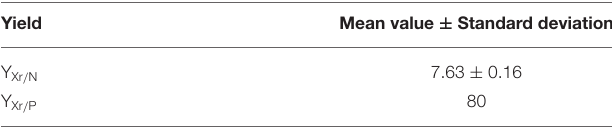
TABLE 2 | Residual biomass yield from nitrogen or phosphorus (g/g) [Y Xr / E ] from the tested conditions.